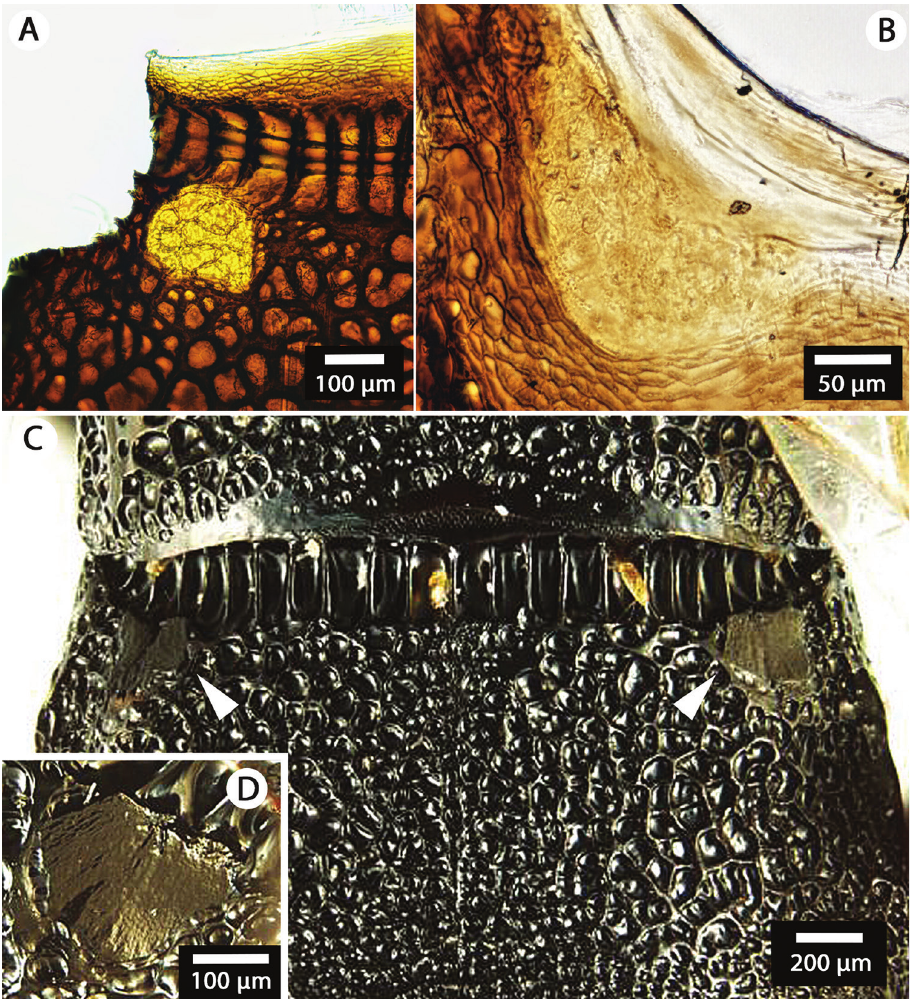
Figure 5. Brightfield images showing the dorsal and ventral patches of translucent cuticle in Orussidae, viewed externally. A Dorsal view of an Orussus sp. (Hymenoptera: Orussidae), viewed externally (identifier: IM 1445/ NCSU 53625) B Ventral view of the same specimen C Arrows pointing to dorsal patches of translucent cuticle in Orussus abietinus Scopoli, 1763 (Hymenoptera: Orussidae) (identifier: PSUC_FEM 86200) D A closer view of one of the translucent patches from the same